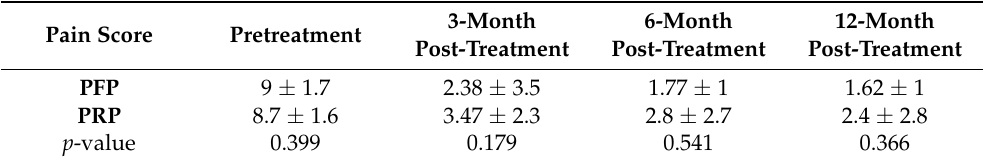
Table 1. Visual Analog Score (VAS) between PRP to PPF treatments.